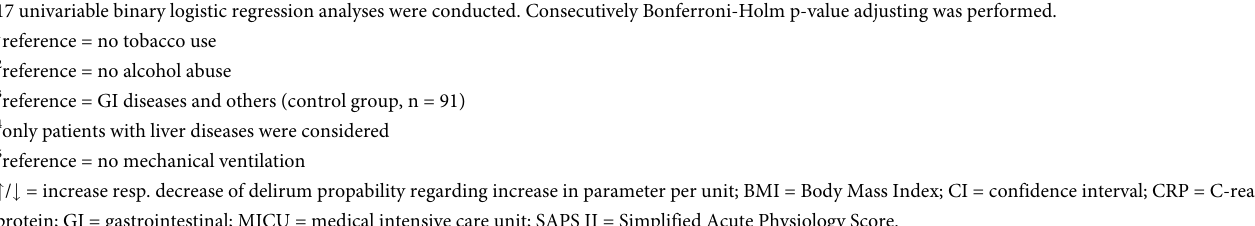
revealed that patients with liver diseases or sepsis were significantly more likely to develop delirium compared to patients with GI and other diseases (= control group) (44.4% resp. 55.6% vs. 19.8%, p = 0.030 and p = 0.016, respectively) (Fig 3B). Furthermore, there was a trend that patients with liver disease suffered more frequently from the hypermotoric form of delirium than patients with sepsis (15.0% vs. 0%) (Fig 3C and 3D). Risk prediction of delirium in the MICU–identification of 10 relevant risk factors Univariable analyses with Holm-Bonferroni correction showed a significant impact of 10 clini- cally relevant risk factors associated with the development of delirium. These include alcohol abuse (p = 0.016), severity of disease (Simplified Acute Physiology Score II, p = 0.016), liver diseases (p = 0.030) and sepsis (p = 0.016) compared to the control group (gastrointestinal (GI) diseases and others), elevated sodium (p = 0.016), creatinine (p = 0.030), urea (p = 0.032) or bilirubin (p = 0.042), decreased hemoglobin (p = 0.016), and mechanical ventilation (p = 0.016) (Table 4, Fig 4).